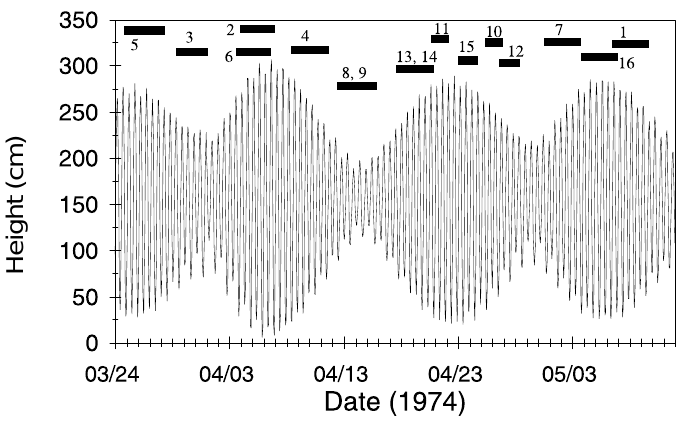
Fig. 6 – Predicted tides for Itaparica (see Figure 3 for location) and the time span of current measurements for each station (for station identification see Table